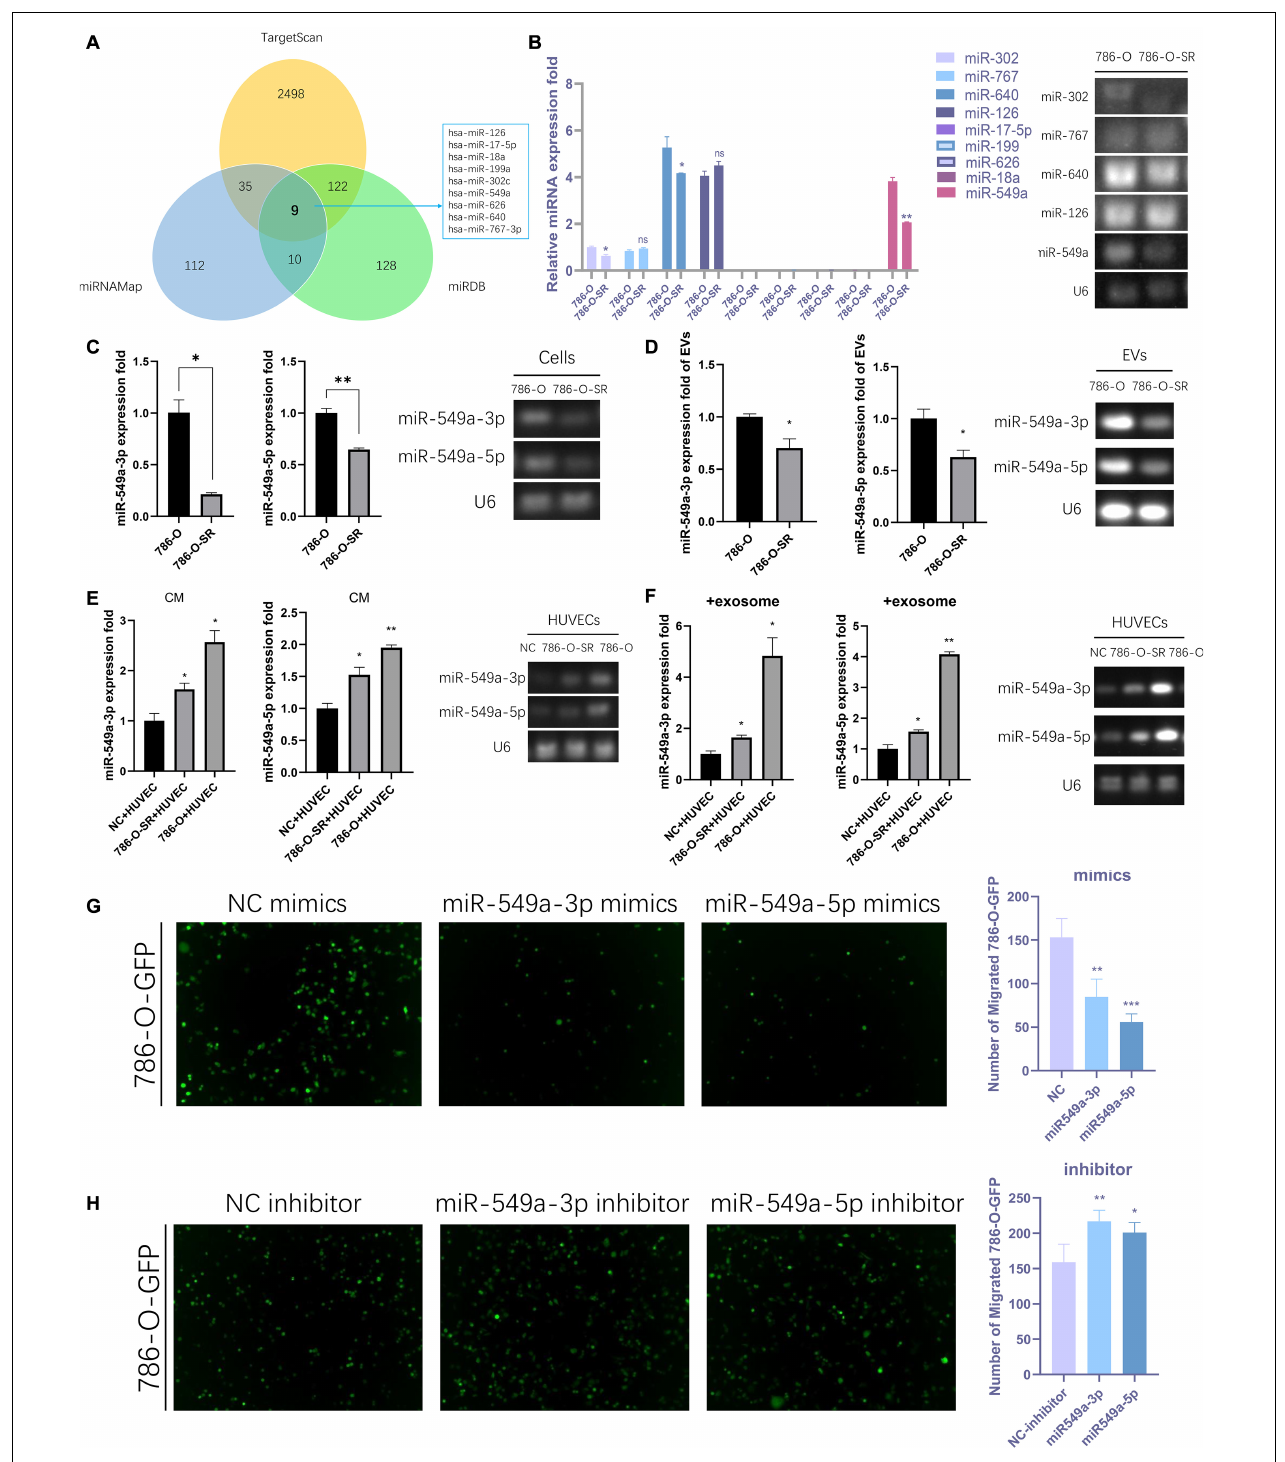
FIGURE 3 | Exosomal miR-549a affects vascular permeability. (A) The Wayne figures of overlapping and different miRNAs which target HIF1 α according to TargetScan, miRNAMap and miRDB. (B) RT-PCR analysis of 9 miRNAs (which target HIF1 α ) expression in 786-O/786-O-SR cells and gel electrophoresis of PCR products. (C–F) RT-PCR and gel electrophoresis of PCR products analysis of miR-549a-3p/miR-549a-5p expression in 786-O/786-O-SR cells (C) , exosomes (D) , HUVECs treated with 786-O/786-O-SR CM (E) or exosomes (F) . (G,H) Transendothelial invasion assay analysis of the number of GFP-expressing 786-O cells that invaded through HUVECs monolayers transfected with miR-549a-3p/miR-549a-5p mimics (G) or miR-549a-3p/miR-549a-5p inhibitor (H) . Mean ± SEM are provided ( n = 3). * P < 0.05, ** P < 0.01, *** P < 0.001, according to two-tailed Student’s t -test. ns, not significant.